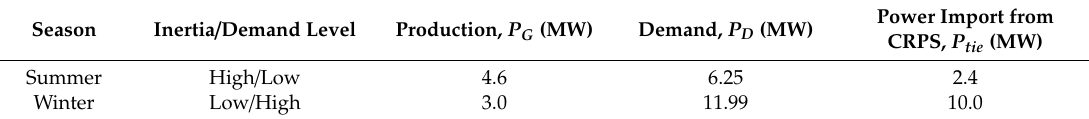
Table 1. Winter and summer operational scenarios of AURPS.